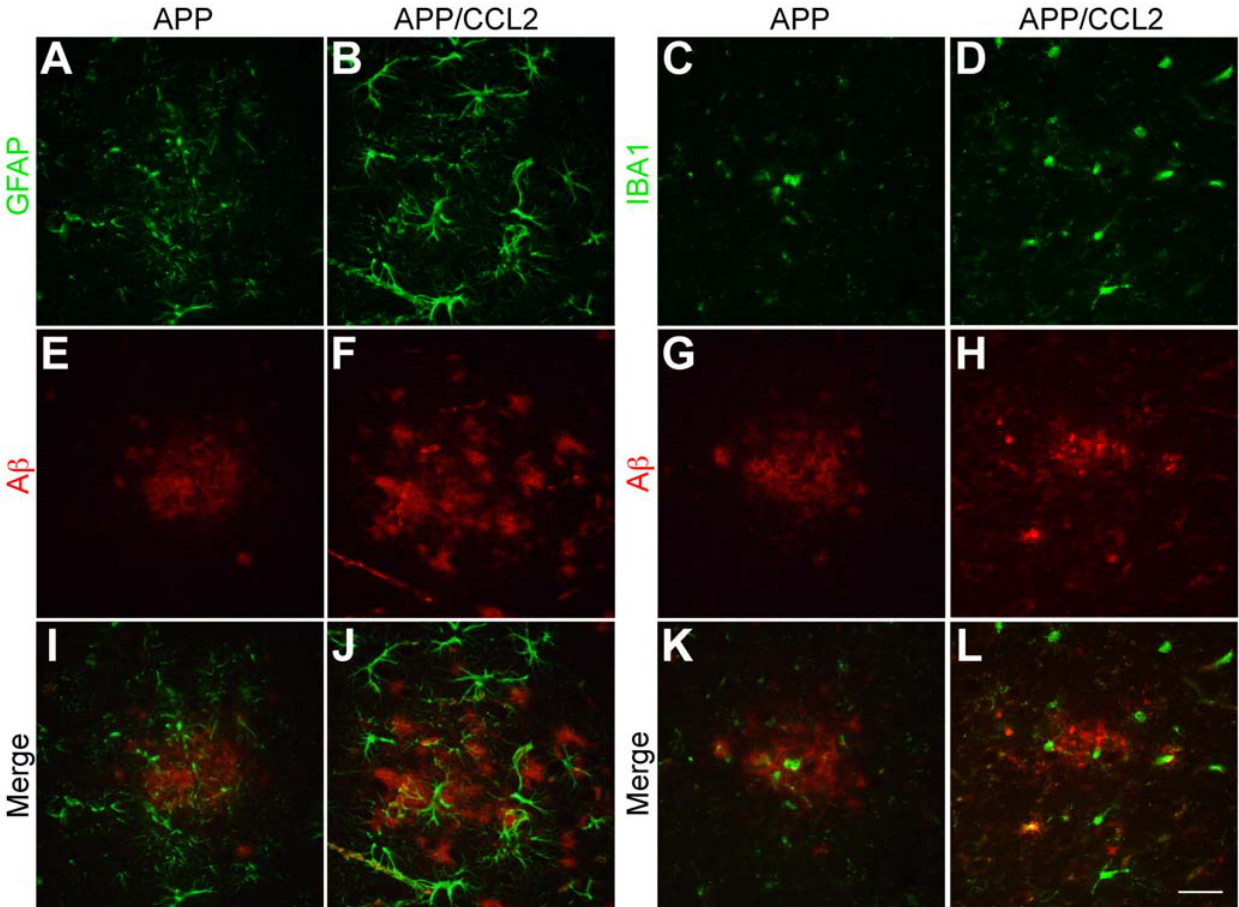
Figure 4. Accumulation of astrocytes and microglia to A b deposits. Frozen sections (10- m m thickness) of temporal cortex of APP and APP/ CCL2 mice at 9 months of age were subjected to double immunofluorescence for GFAP (A–B, green) or IBA1 (C–D, green) and A b (NU-1) (E-H, red). (I– L) Merged images. Scale bar, 50 m m.